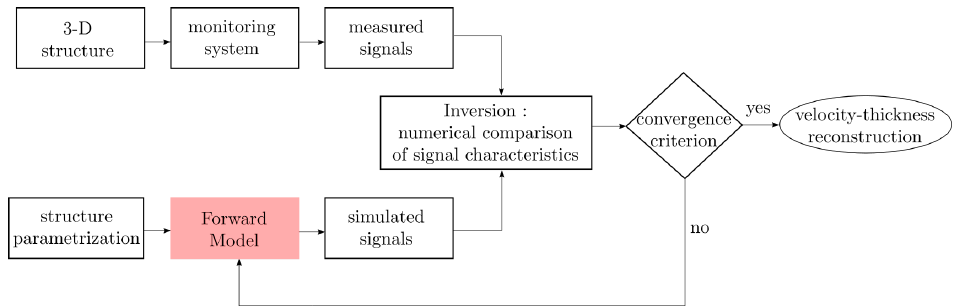
Figure 1. Flow chart of the GWT algorithm: real data (measured signals) and synthetic data (from forward model) are compared iteratively until a given residual criteria is reached. The role of the forward model is